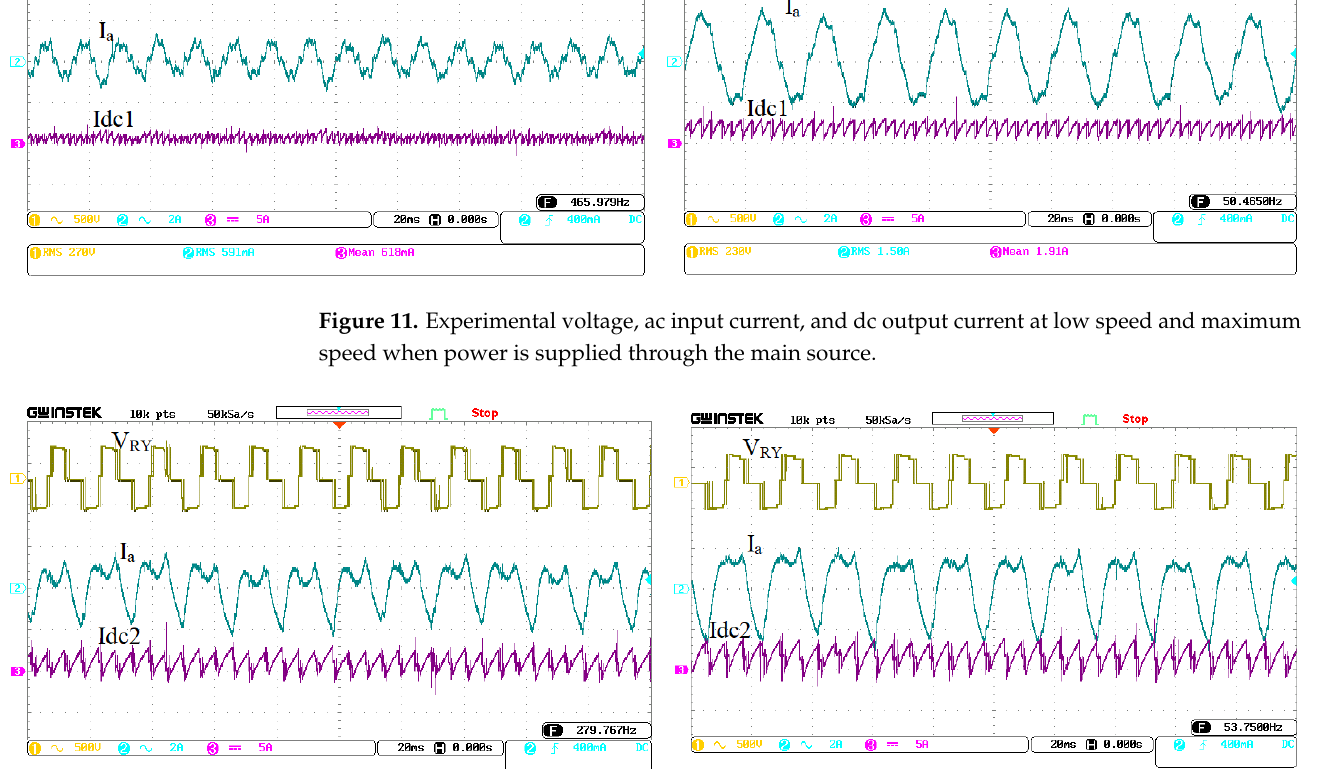
Figure 12. Experimental voltage, ac input current, and dc output current at low speed and maximum speed when power is supplied through the supplementary source.